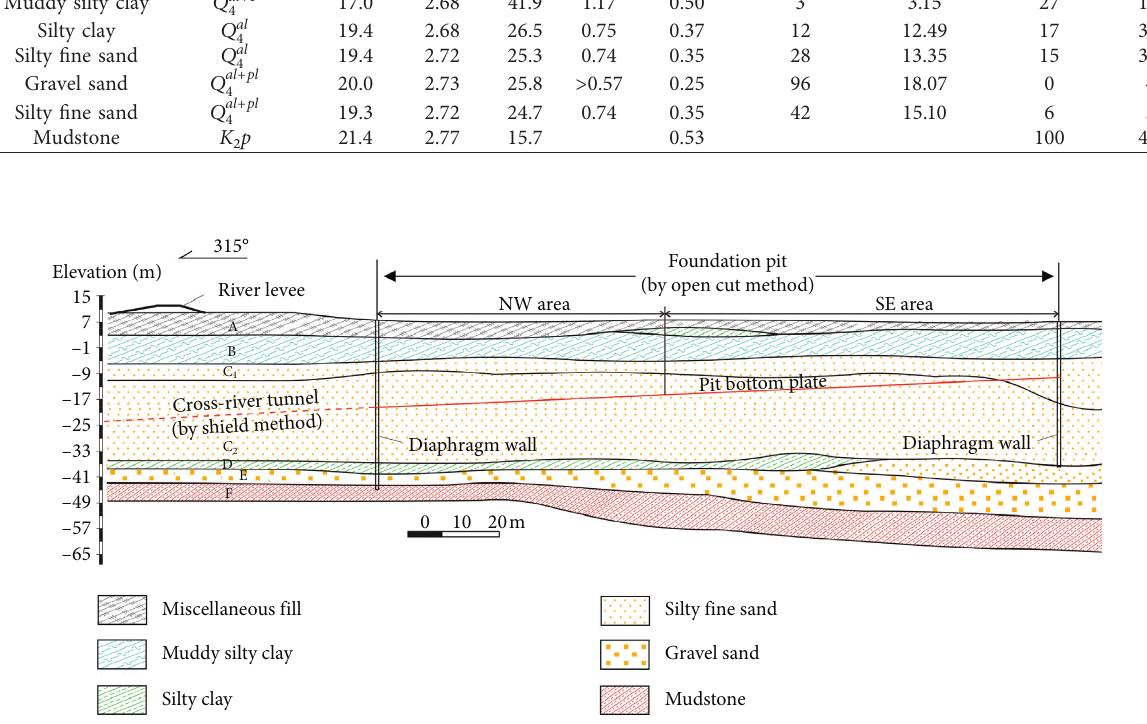
Figure 2: Profile of the strata and foundation pit in section 1-1 ′ shown in Figure